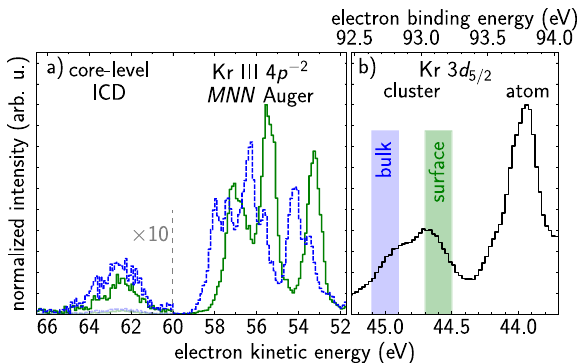
Fig. 2 Coincidental 3 d 5/2 photoelectron, Auger and ICD electron spectra. a High-energy Auger and core-level ICD electrons detected in coincidence with 3 d 5/2 photoelectrons from bulk (blue dashed) and surface (green solid) of Kr clusters each normalized to equal area of the M 5 N 2,3 N 2,3 Auger spectrum between 52.1 and 59.2 eV kinetic energy. b Spectrum of the Kr 3 d 5/2 photoelectron measured in coincidence with Auger or core-level ICD electrons for atoms and clusters in a partially condensed cluster jet. The cluster signal is additionally split into surface and bulk signals. The blue and green shaded areas indicate the electron kinetic energy ranges used to identify the coincident events shown in a